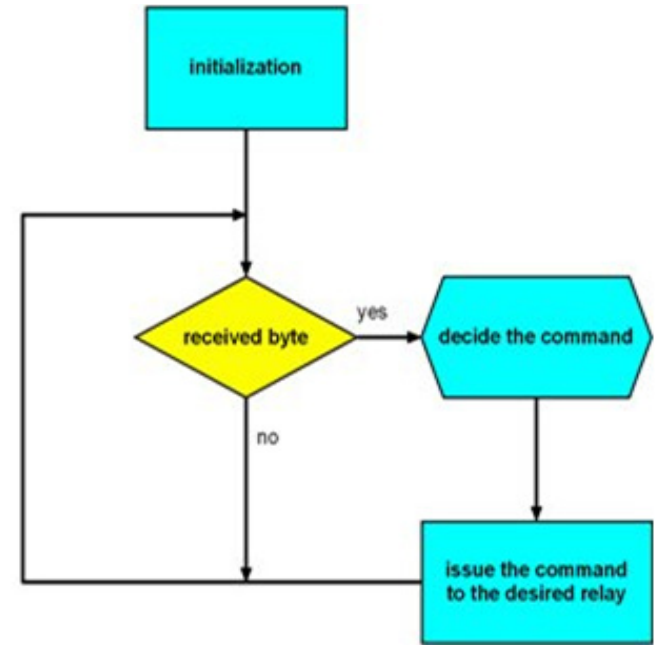
Fig. 5. PIC microcontroller code flow